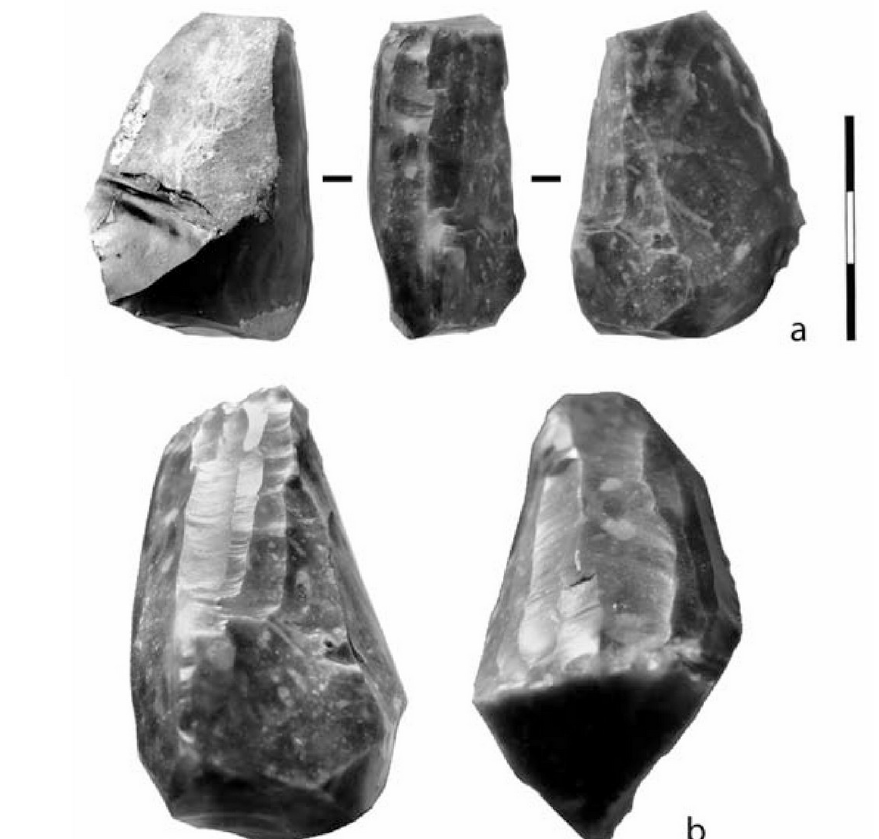
Figure 9. La “Bouche d’Oise”, nucléus à lamelles débité par pression (Gueret et al. 2009). (L’échelle est de 3 cm divisée en segments de 1 cm.) Figure 9. La “Bouche d’Oise”, bladelet core with pressure technique (Gueret et al. 2009). (Scale bar is 3 cm wide, divided into 1 cm